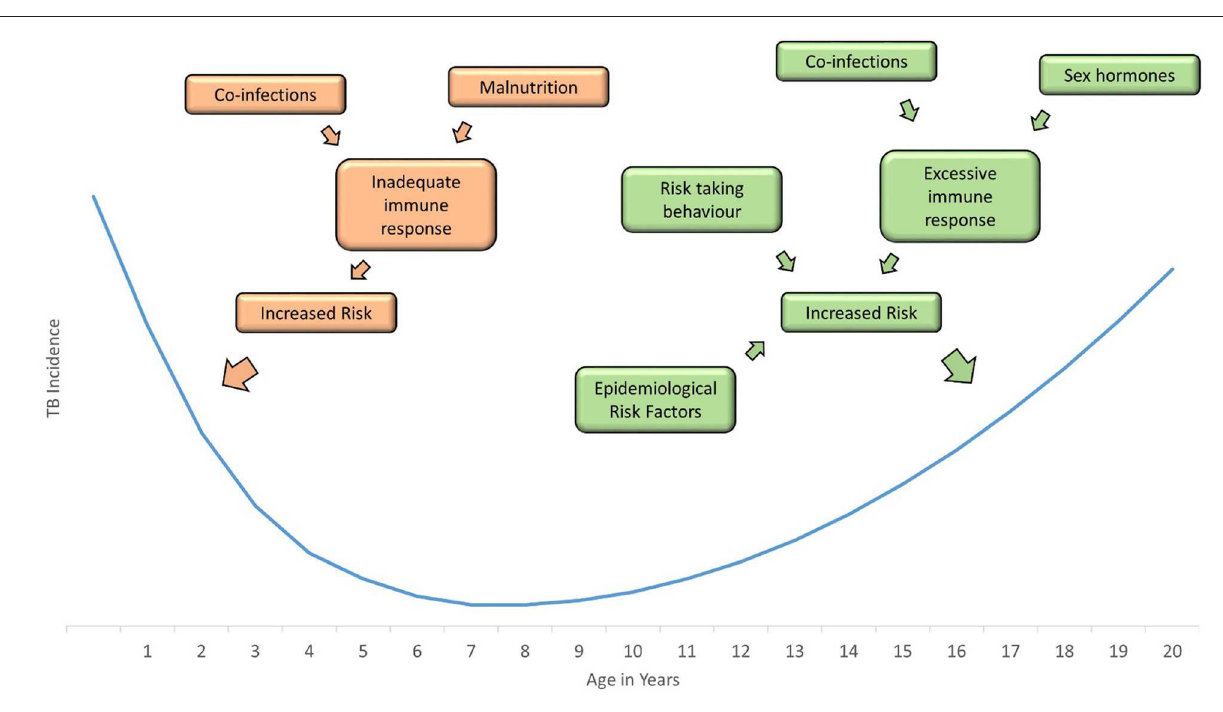
and CD8 + T cells promoting their activation (14). Absence of TNF- α is associated with progression to severe TB disease, as seen following treatment with anti-TNF monoclonal antibodies for